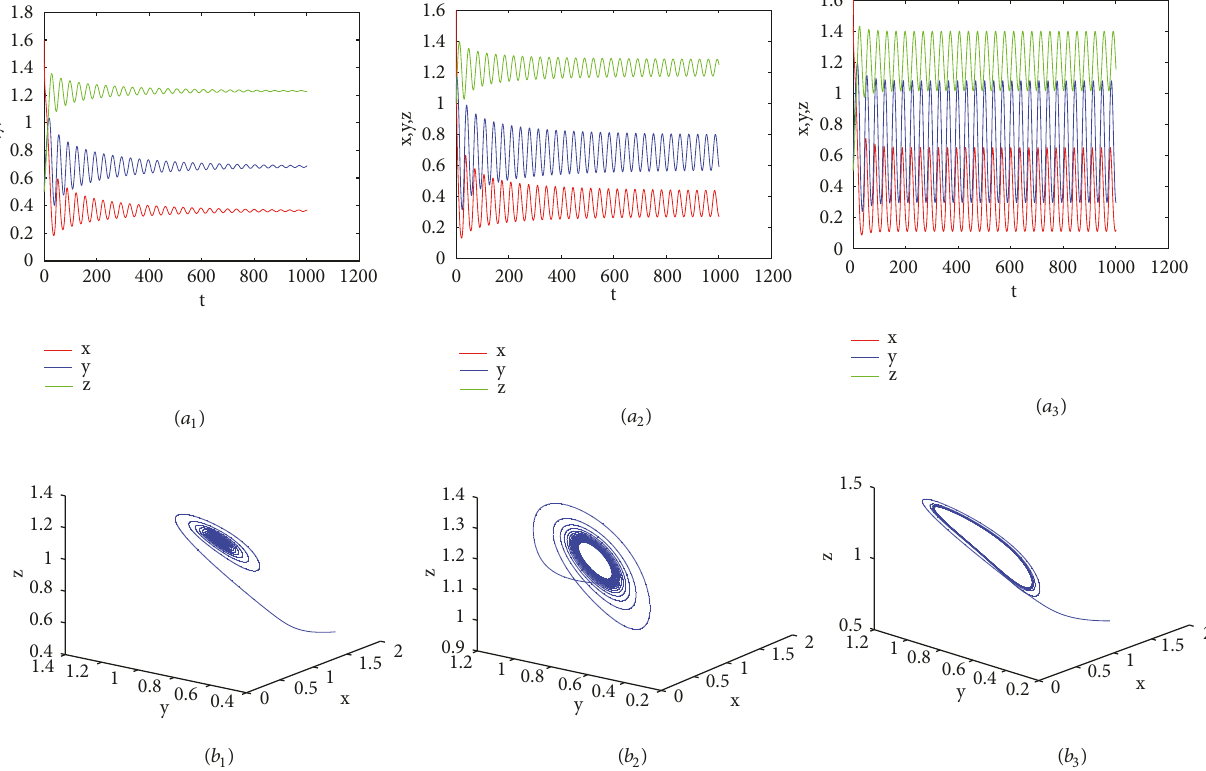
Figure 5: Time series plots and the three-dimensional space graphs of the tritrophic food chain model for Experiment 3 with different parameters: (𝑎) and (𝑑)𝑗 = 7 ; (𝑏) and (𝑒)𝑗 = 9 ; (𝑐) and (𝑓)𝑗 = 12 .